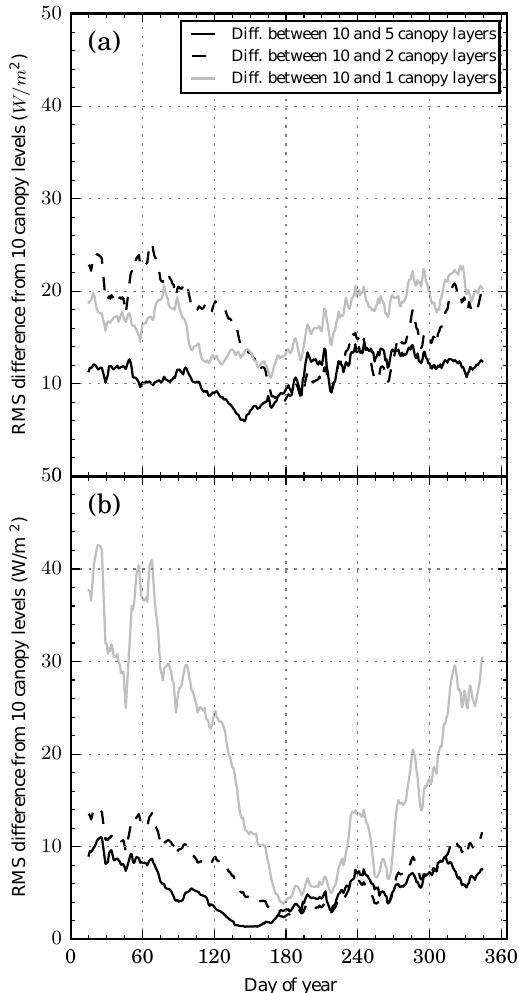
Figure 9. As for Fig. 8 for a set-up with 10 canopy layers (out of 30 total profile levels), 5 canopy layers (of 15 total profile levels), 2 canopy levels (of 8 total profile levels), and 1 canopy levels (of 5 total profile levels), for a run over the course of a year, expressed as a daily average (a) 20-day moving average of the root mean square difference of the daily mean of sensible heat flux; (b) as (a)